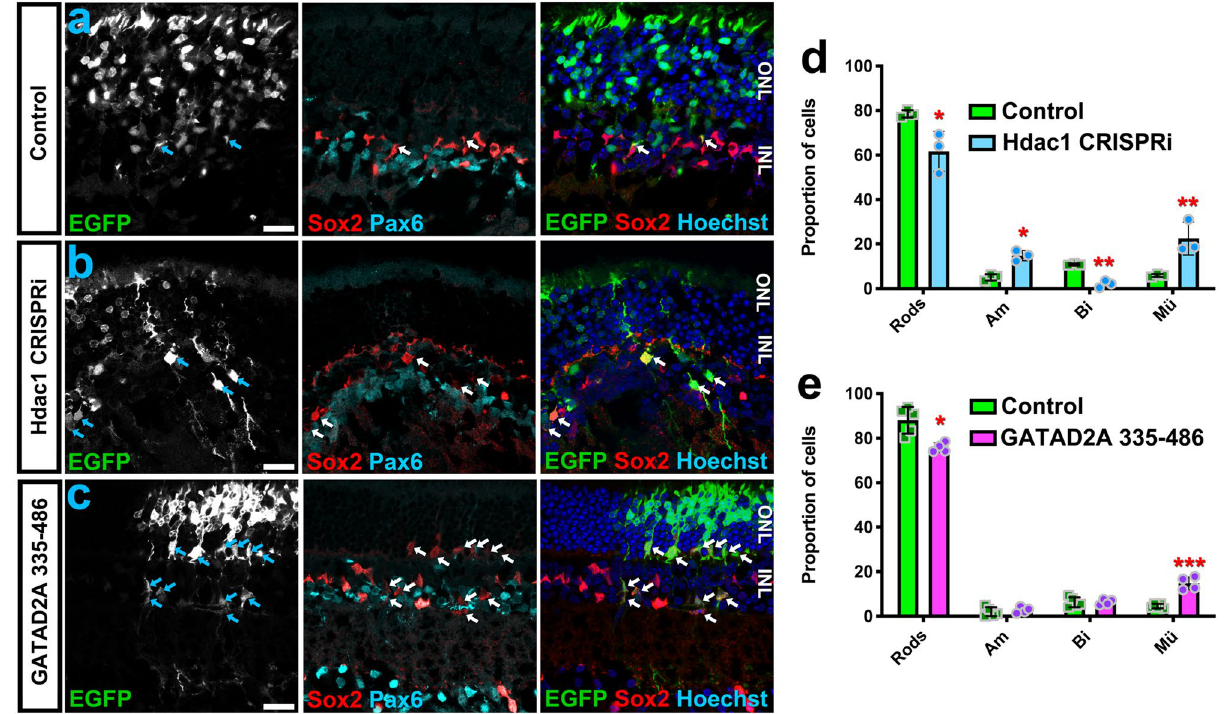
Figure 4. Hdac1 and NuRD regulate the rod versus Müller fate choice. ( a–c ) In vivo electroporation of P0 retinas with ( a ) Control (pCIG2 + dCas9-KRAB-MeCP2; n = 3), ( b ) Hdac1 CRISPRi (n = 3), or ( c ) GATAD2A-335-446 (n = 4). Retinas were harvested at P21 and stained for Sox2, Pax6, and DNA (Hoechst). Arrows indicate GFP + Sox2 + Müller glia, some of which are ectopically positioned in the ONL. Scale bars = 20 microns. ( d,e ) Quantitation of transfected cell fate. See Table S4 for statistical